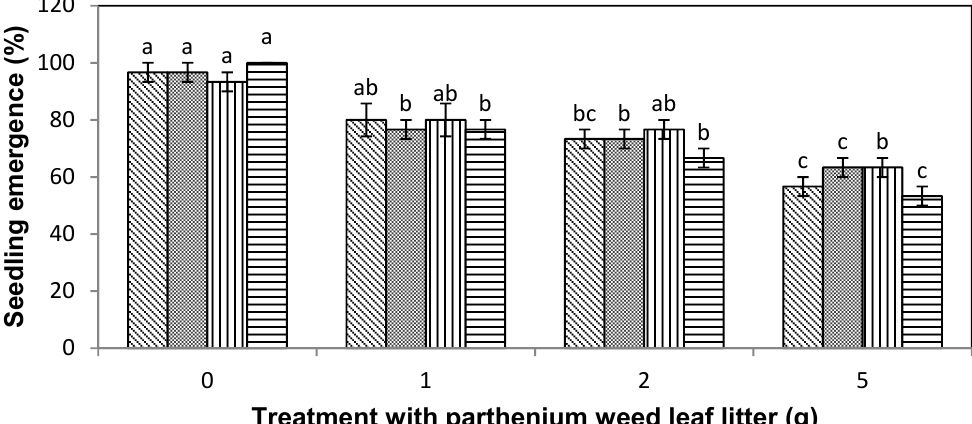
Figure 4. Seedling emergence of lettuce ( ), maize ( ), curly windmill grass ( ), and liverseed grass ( ) when sown into compost amended with different amounts of parthenium weed leaf litter (either 0, 1, 2, or 5 g) for 30 days. Error bars represent two standard deviations from the mean as calculated for three replicates of three seedlings. Means within each treatment that do not share the same letter are significantly different from one species to another at p > 0.05.